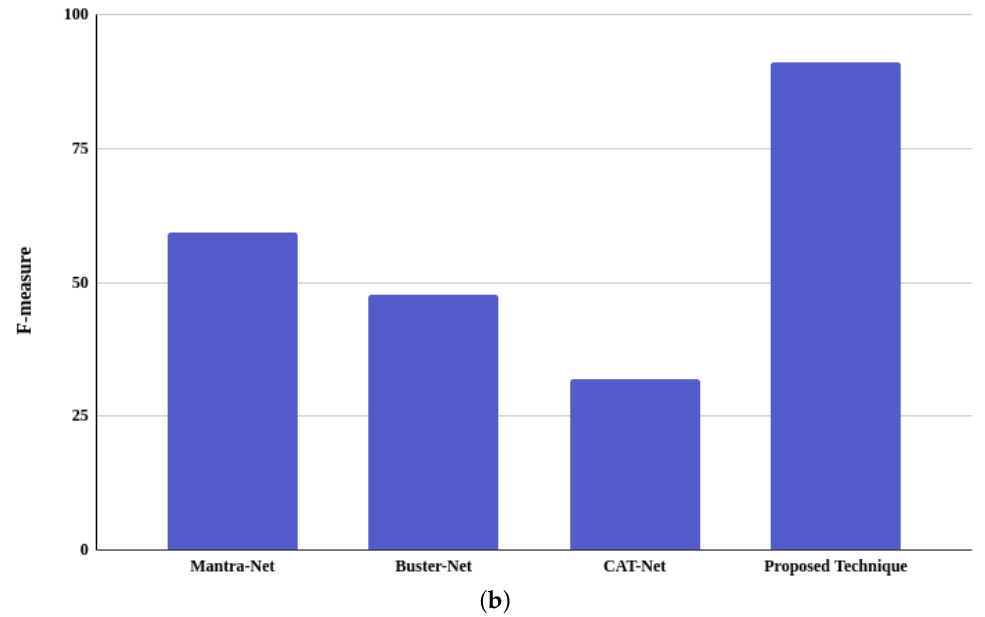
Figure 8. Comparison of the performance of Mantra-Net [3], Buster-Net [27], CAT-Net [2], and the proposed technique in terms of: ( a ) accuracy, ( b ) F measure .